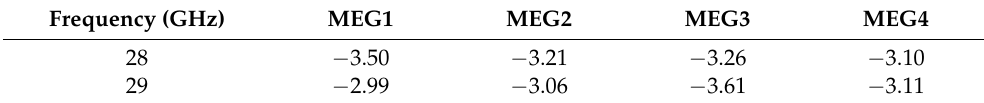
Table 1. Mean Effective Gain of the proposed Antenna at 28 and 29 GHz Frequency.